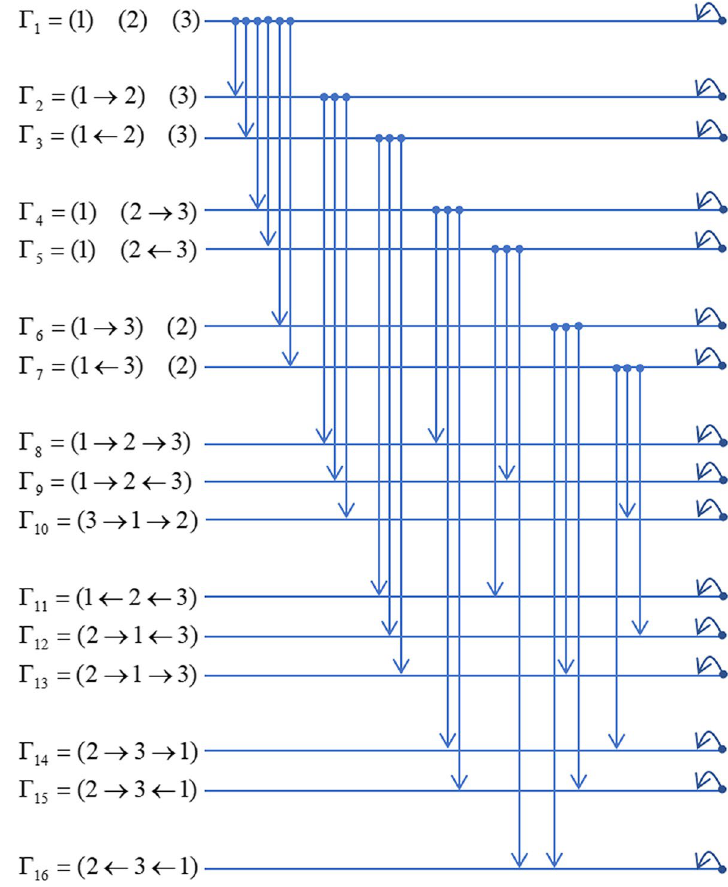
Fig. 3 Transition of possible coalitional structures for a case of 3